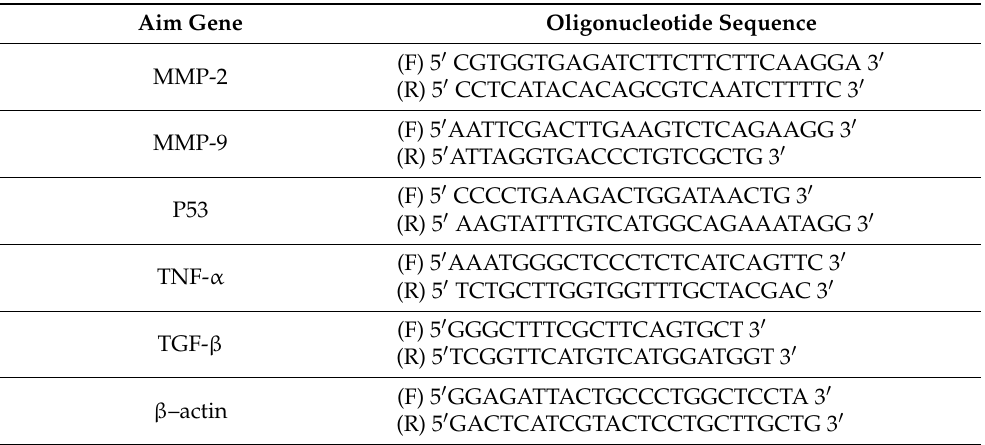
Table 1. Primers and probes used in quantitative real-time PCR